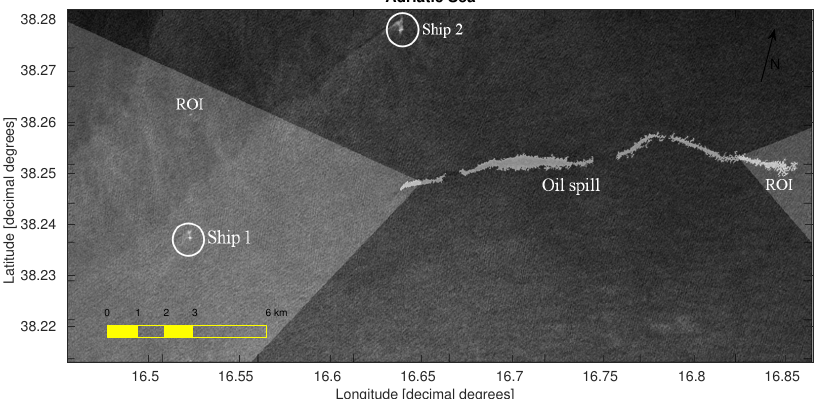
Figure 20. Enhanced image with spill and ROI superimposed, Ionian Sea dataset.